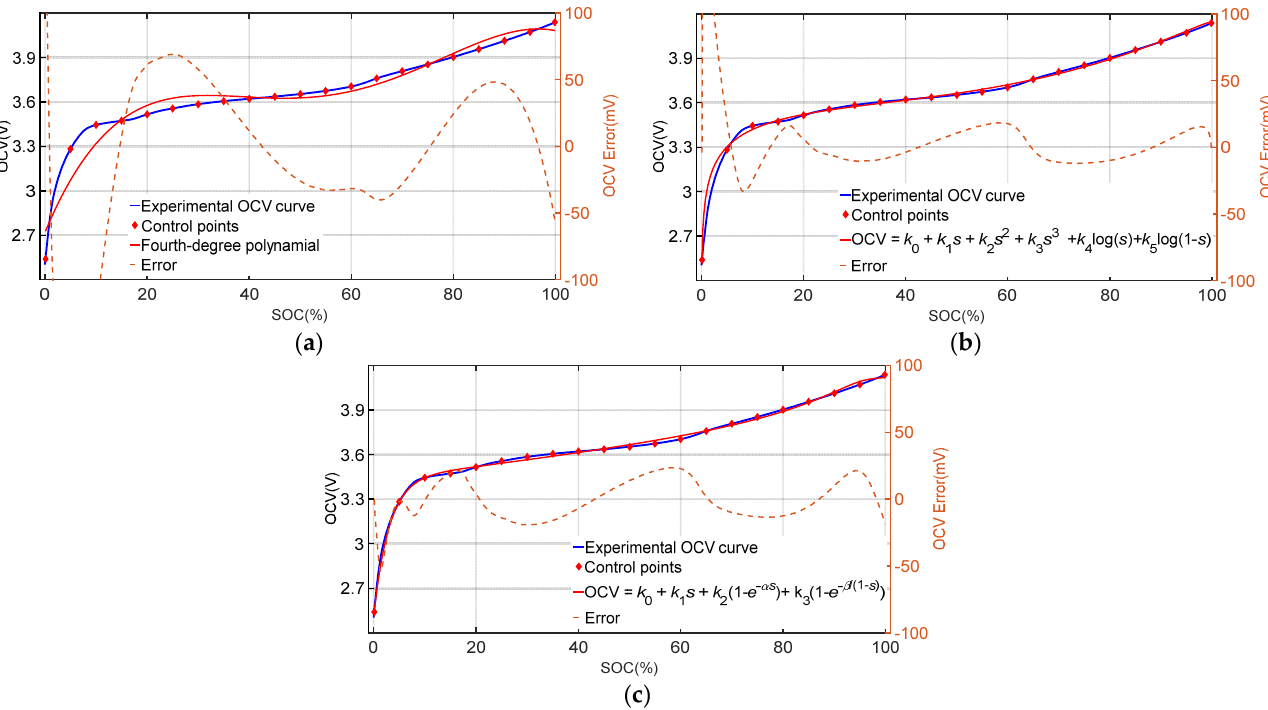
Figure 2. Conventional open circuit voltage (OCV) models for LiNiMnCoO 2 (NMC) battery (21 control points, s denotes state of charge (SOC), k 0, 1, 2, 3, 4 , α , β denote fitting coefficients). ( a ) Fourth-degree polynomial. ( b ) Polynomial and logarithm. ( c ) Exponent and linear function.